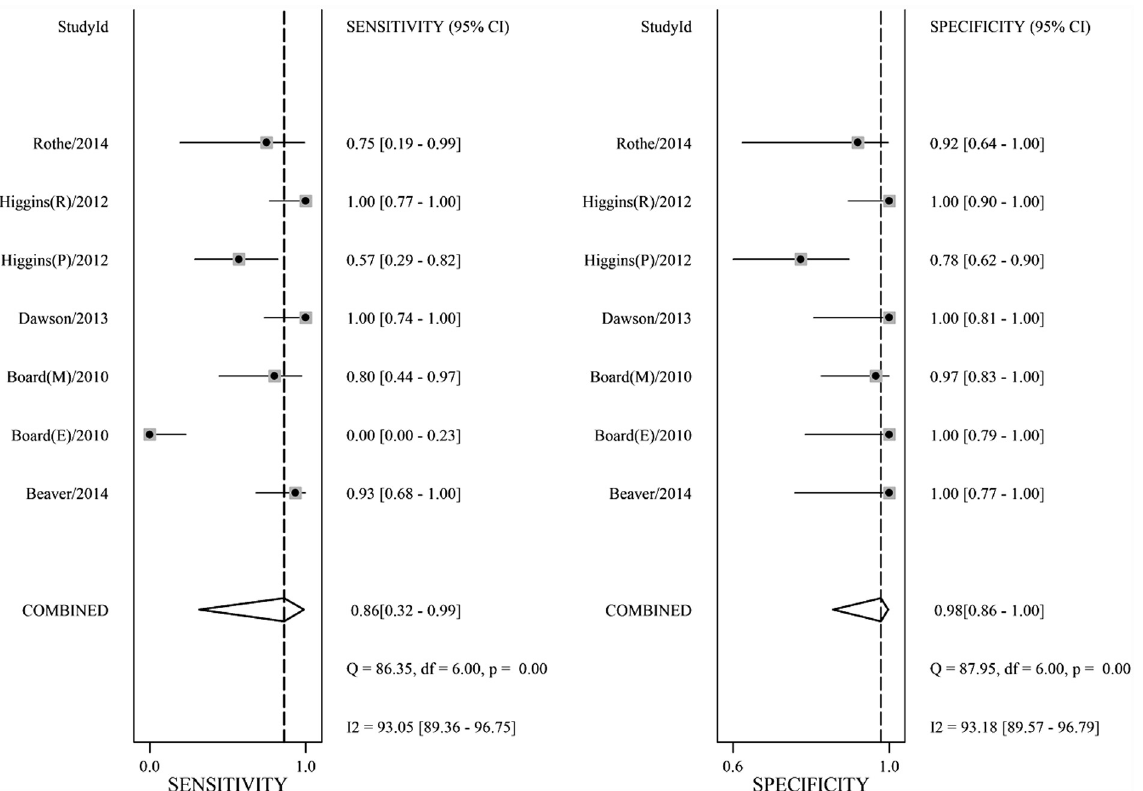
Fig 2. Forest plot showing study-specific and overall sensitivities and specificities with corresponding heterogeneity evaluation.